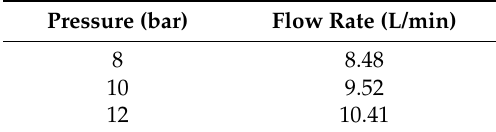
Table 1. Nominal flow rate provided by a single nozzle of the agitation system at different working pressures.